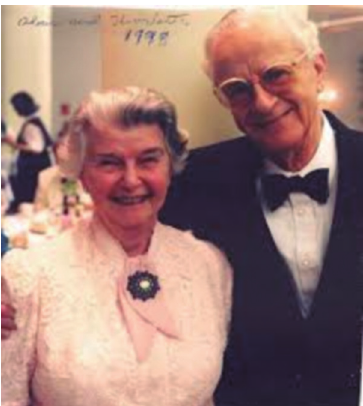
Figure 1. Professor Henrietta C. Leiner and her husband Alan L. Leiner (1998). (Extracted from Google Images: link springer.com, September, 18 th ,